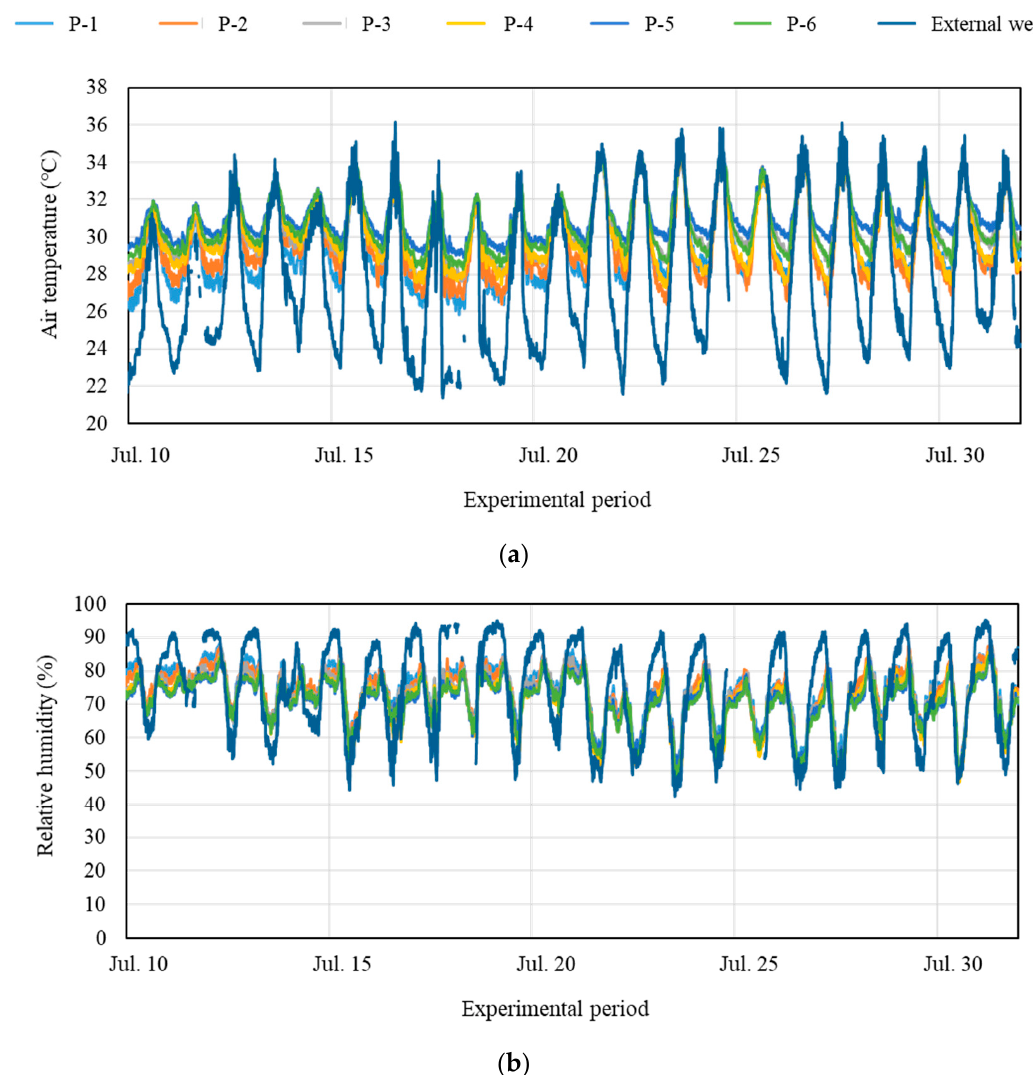
Figure 8. The results of measured air temperature and relative humidity inside the fattening pig house. ( a ) Air temperature. ( b ) Relative humidity. house. ( a ) Air temperature. ( b ) Relative